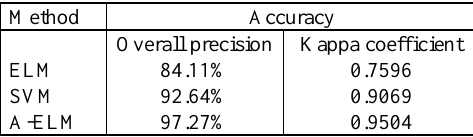
Table 2. Accuracy comparison on Wuhan image experiment